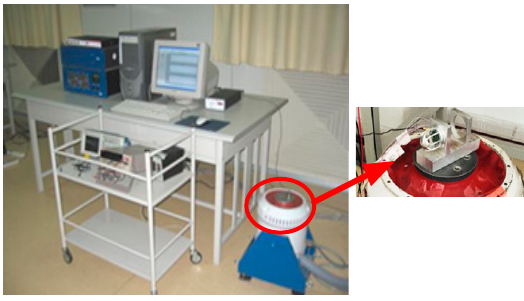
Figure 20. Vibration platform test site.